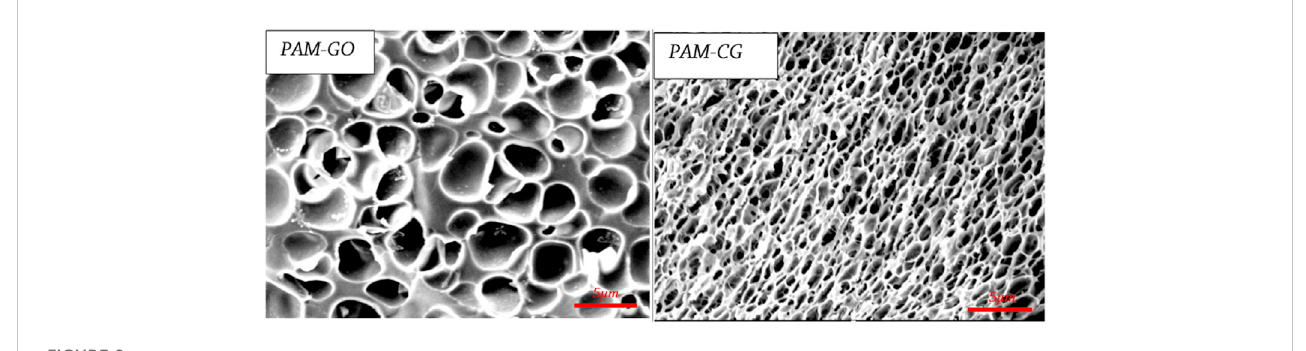
FIGURE 9 SEM images of PAM-CG and PAM-GO (Michael et al., 2020).